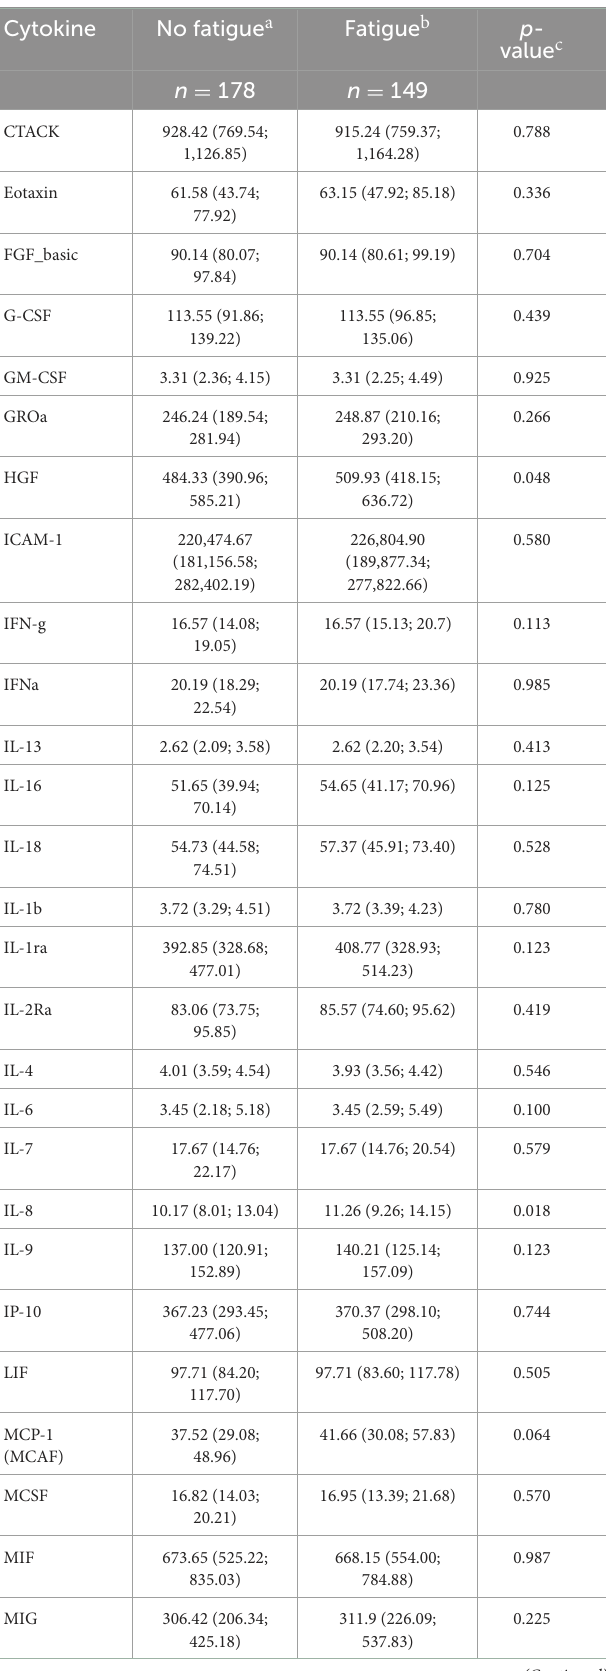
TABLE 2 Serum levels of cytokines (pg/ml; median, 25% quantile; 75% quantile) in 327 individuals with and without fatigue in the “Stroke Cohort Augsburg” (SCHANA)